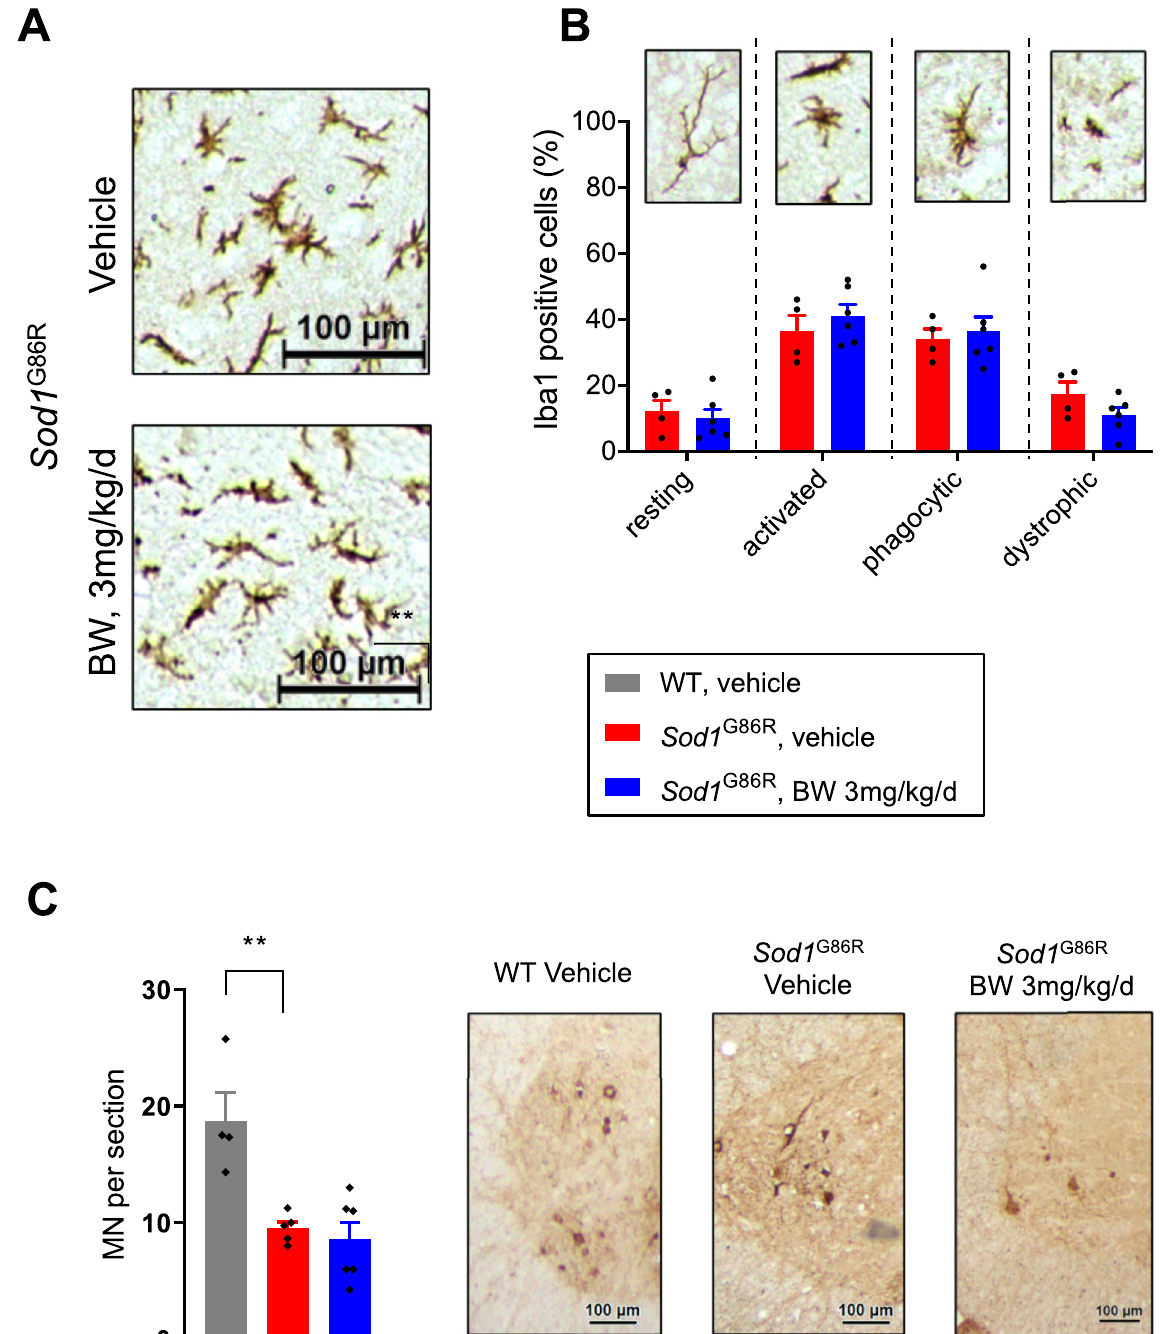
Figure 5. BW treatment does not modify microglia morphology and motor neuron degeneration in Sod1 G86R mice. ( A ) Representative Iba1 immunostaining of Sod1 G86R mice, treated with a vehicle (upper panel) or with 3 mg/kg/d of BW (lower panel). ( B ) Relative quantification of resting, activated, phagocytic and dystrophic Iba1 + cells. Sod1 G86R control animals are displayed in red (N = 4) and animals treated with 3 mg/kg/d of BW in blue (N = 6). Representative morphology of each microglial state is given on top of the graphic. ( C ) Motor neuron quantification in lumbar spinal cord. WT animals are displayed in grey (N = 4), Sod1 G86R control animals are displayed in red (N = 5) and animals treated with 3 mg/kg/d of BW in blue (N = 6). All graphs presented as mean +/− SEM. t-test. * p < 0.05. Representative ChAT immunostaining of wild type (left) and Sod1 G86R mice treated with either vehicle (middle) or BW at 3 mg/kg/d